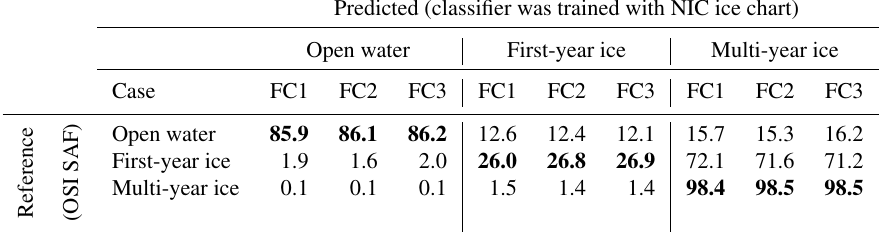
Table 12. Confusion matrix of the three-class RF classifier which was trained with the DS1 winter dataset and applied to the DS2 winter dataset with reference to the OSI SAF sea ice type product (OSI-403-c). Bold indicates where the classification was done correctly.